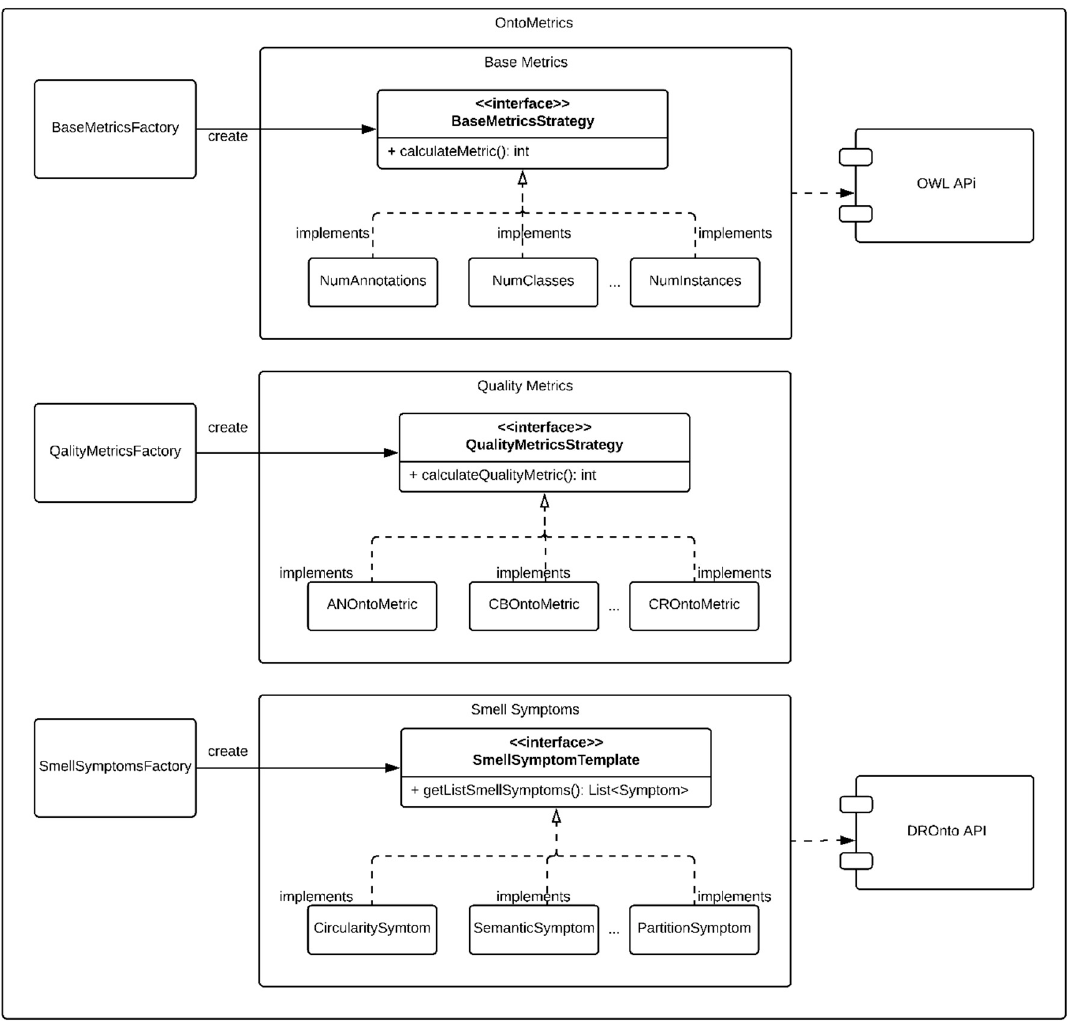
Figure 5. OntoMetrics design.